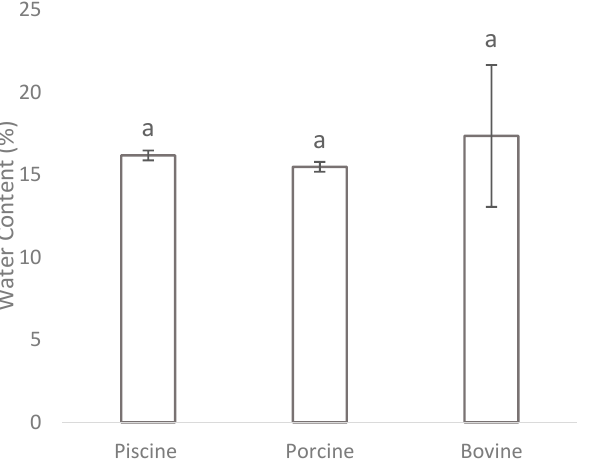
Figure 3. Water content of bioplastics generated from porcine, piscine, and bovine gelatine. Values represent an average of n = 3; error bars represent standard deviation with different lowercase letters representing significantly different values.